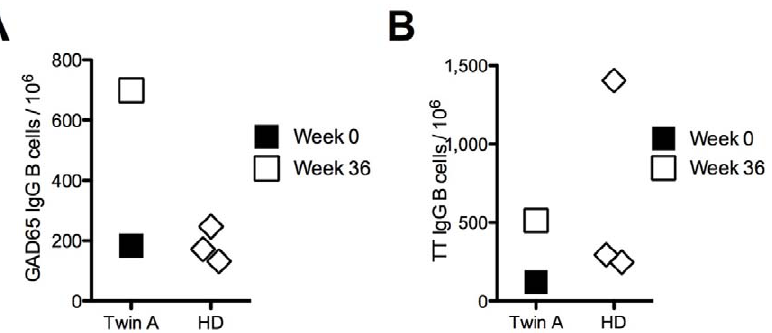
Figure 2. Relative increase in frequency of specific memory B cells after rituximab treatment. Frequency of IgG + memory cells specific for GAD65 (A) and TT (B) was analyzed by limiting dilution assays at week 0 and 36 for twin A, and for three healthy donors (HD).